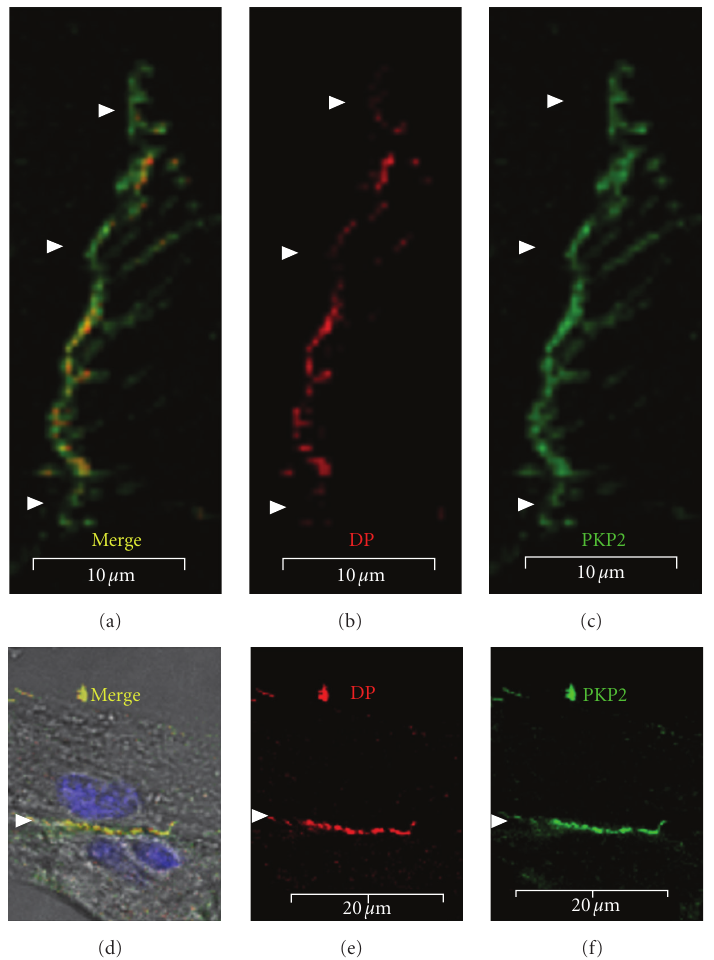
Figure 6: Localization of DP to a subset of adhesive sites. ARCs were immunolabeled with antibodies to desmoplakin (red: a, b) and PKP-2 (green: a, c) on days 5 (a)–(c) and 7 (d)–(f) post plating. The absence of DP from some of the adhesive domains ((a)–(c): arrowheads) suggests that its localization to the newly forming structures occurs after PKP2. DP and PKP2 do fully co-localize at more mature adhesive contacts ((d)–(f): arrowheads). Scale bars are 10 μ m (a)–(c) and 20 μ m (e,